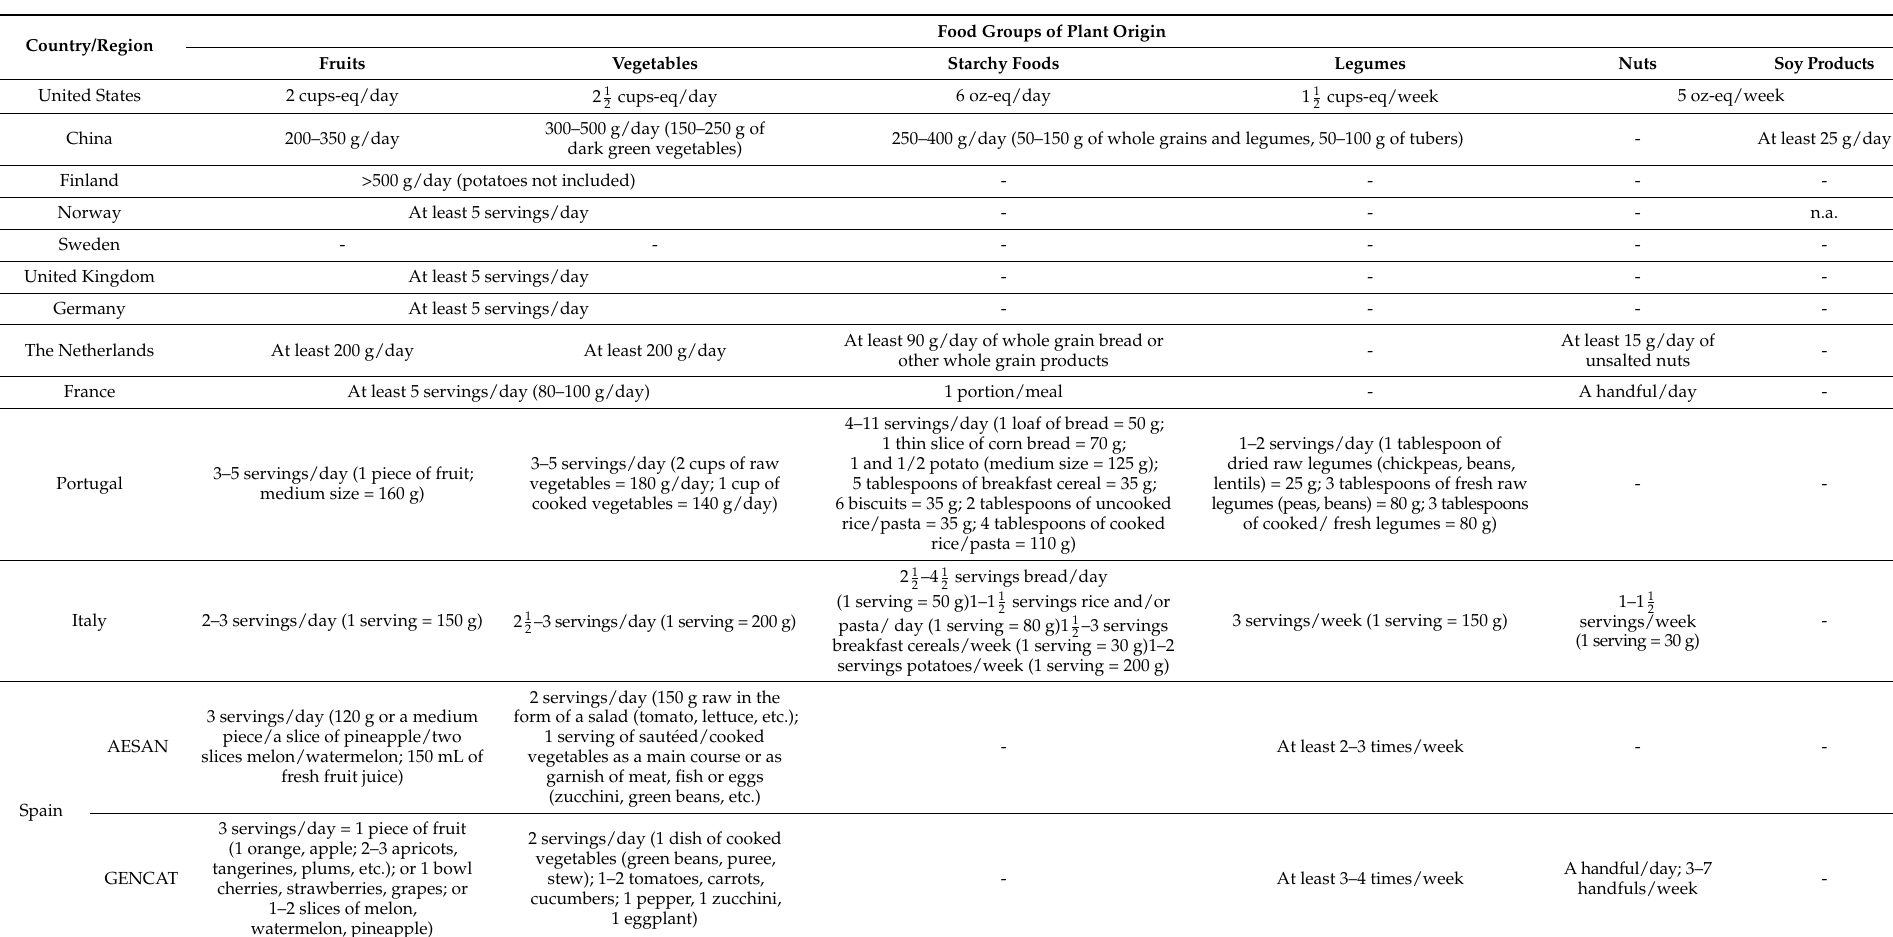
Table 4. Dietary recommendations for food groups of plant origin established by the international food guides selected in the present